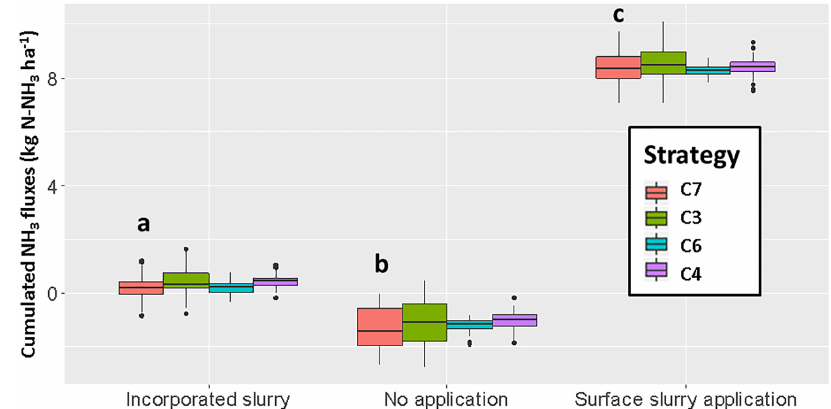
Figure 17. Same as Fig. 16 but grouped by treatments and with additional strategies C4 and C6, which consider that replicates have the same surface flux. The variability in the box plot aggregates the uncertainty on the inference method (the standard deviation on the flux estimate in the least-square model, which accounts for the variability in the replicated concentration measurements), and the variability among the repetitions in each treatment. Letters a, b and c show significant differences among treatments for the C7 strategy, according to a Tukey test (95% family-wise confidence